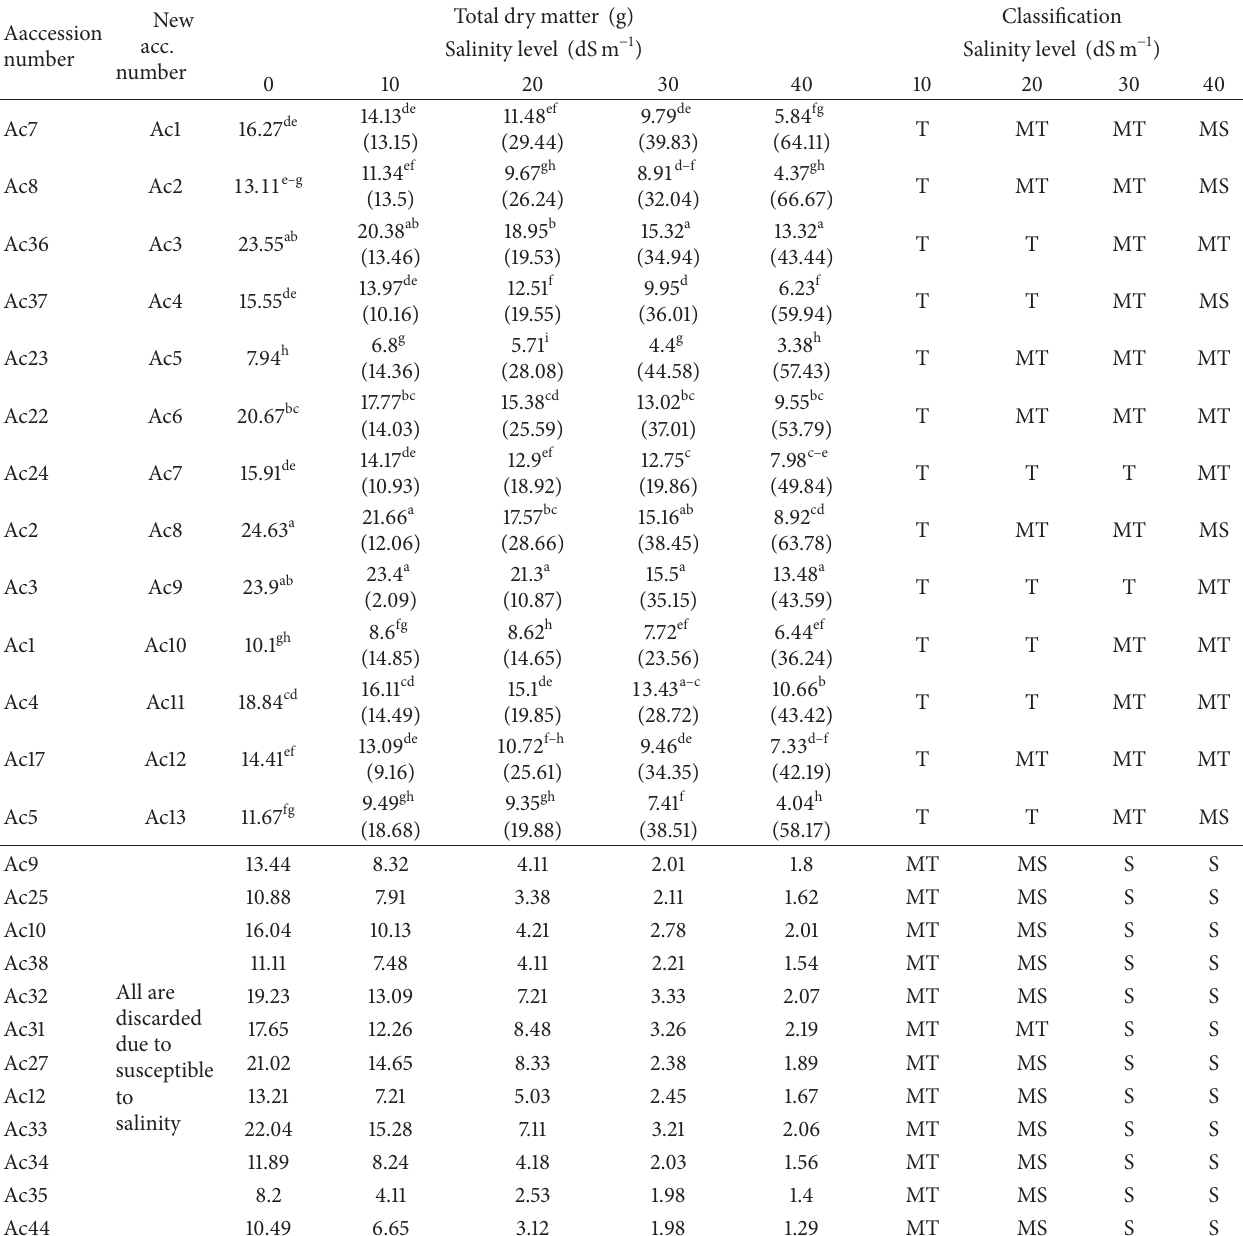
Table 2: Influence of salinity on total dry matter production of purslane plants and their classification to salinity tolerance. Aaccession